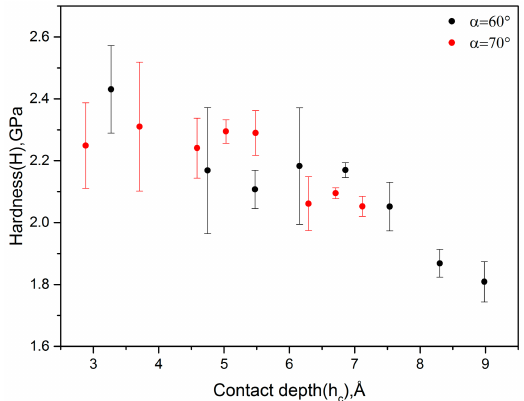
Figure 9. Correlation between hardness and contact depth in wedged nanoindentation with different half vertex angles of 60 ◦ and 70 ◦